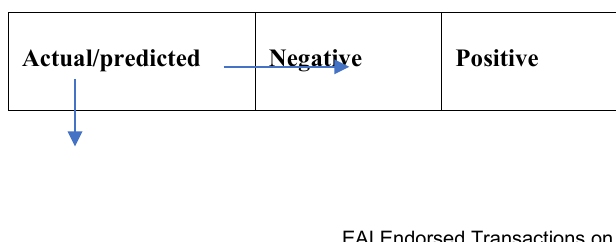
Fig 6. Heat map for all features